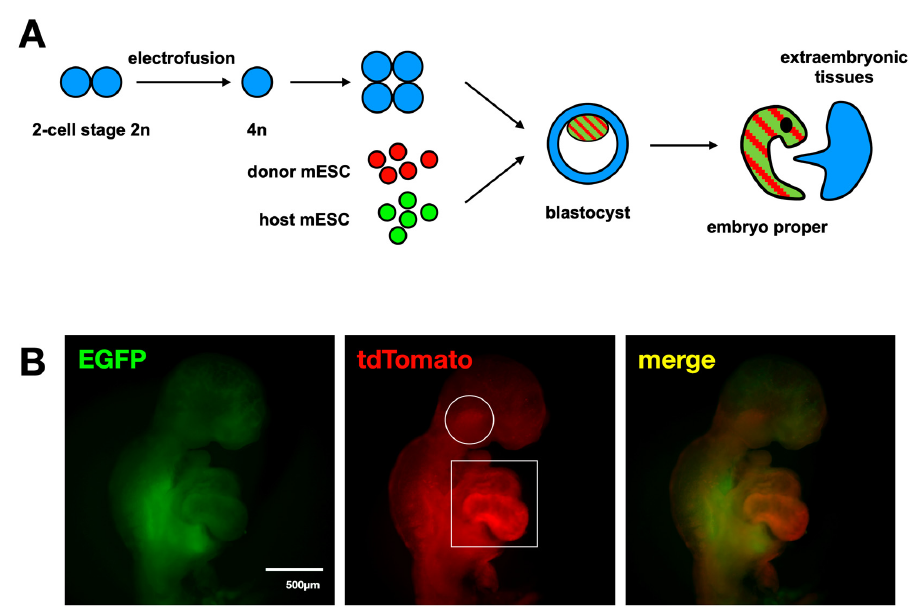
Figure 5. Generation of “host”–“donor” chimeric embryos. ( A ) Schematic describing the generation of chimeric embryos by aggregation of mESC with tetraploid embryos. ( B ) Chimeric embryo showing absence of green fluorescence and increased red fluorescence in the heart tube and pharyngeal arches. Both areas of the embryo originate from the heart fields, which express Nkx2.5 .